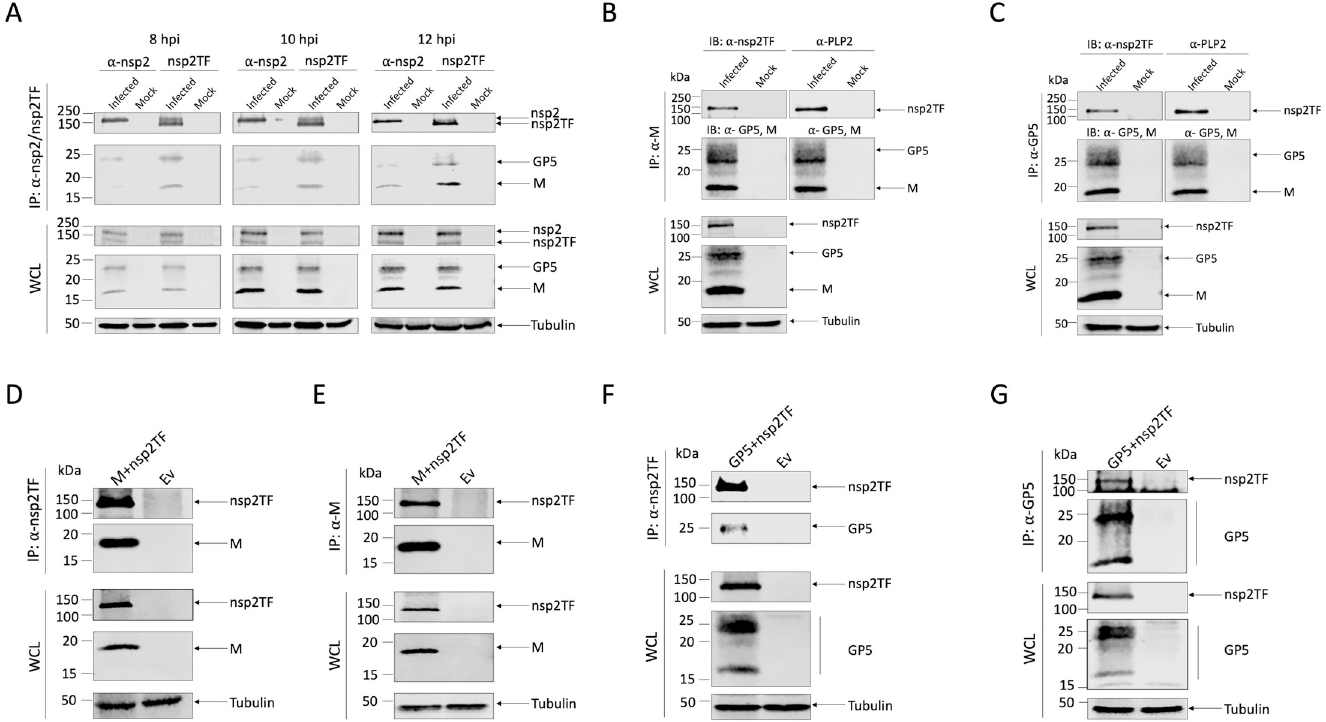
Fig 2. Interaction of nsp2TF with GP5 and M protein. ( A-C ) MARC-145 cells were mock-infected or infected with PRRSV. ( A ) Cell lysates were collected at 8, 10 and 12 hpi and subjected to IP. Lysates were immunoprecipitated with anti-nsp2TF pAb or anti-nsp2 pAb. Western blot analysis was conducted with the whole cell lysate or immunoprecipitated proteins. Membranes were probed with anti-nsp2TF and anti-nsp2 pAbs, or anti-M and anti-GP5 mAbs. ( B-C ) Cell lysates were collected at 12 hpi and subjected to co-IP and western blot analysis. Lysates were immunoprecipitated with anti-M pAb ( B ) or anti-GP5 pAb ( C ) and membranes were probed with anti-nsp2TF pAb, anti-PLP2 mAb, or anti-M and anti-GP5 mAbs. ( D-G ) HEK-293T cells were co-transfected with a plasmid expressing nsp2TF and a plasmid expressing M protein ( D-E ) or GP5 ( F-G ). Cell lysates were collected at 48 h post-transfection and subjected to co-IP using a specific pAb against each individual protein as indicated in each panel. Membranes were probed with anti-nsp2TF pAb, anti-M or anti-GP5 mAb. Anti-tubulin mAb was used as a control. IP: immunoprecipitation; IB: immunoblotting; WCL: Whole cell lysates; Ev: empty vector.